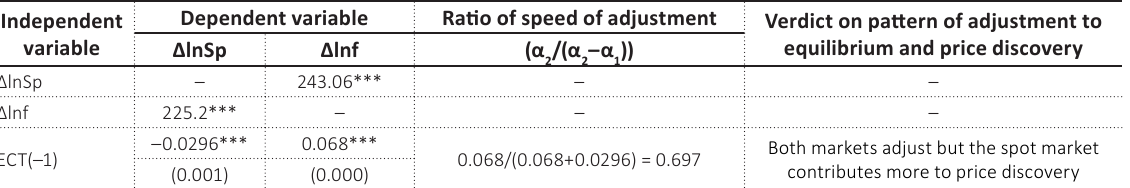
Table 3. Panel VECM results